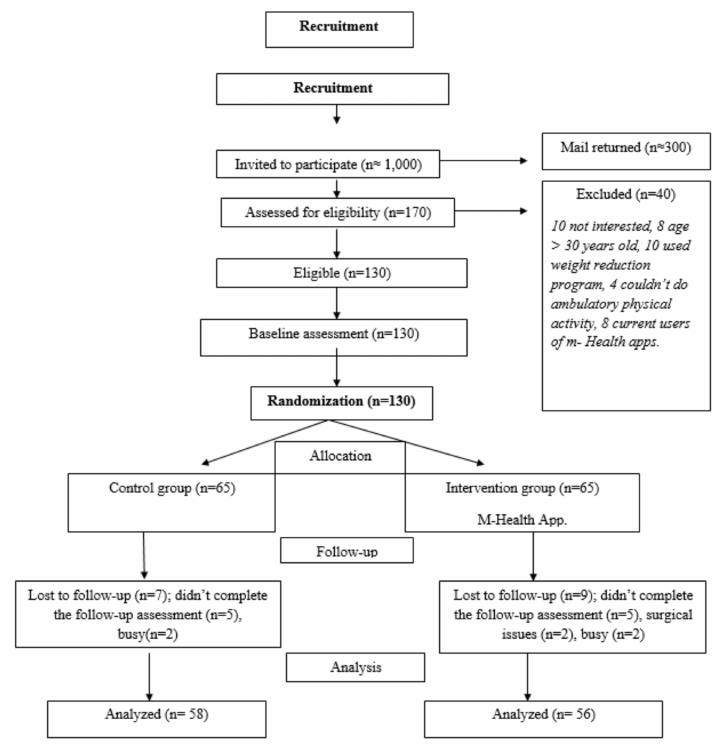
Figure 1. Participant flow